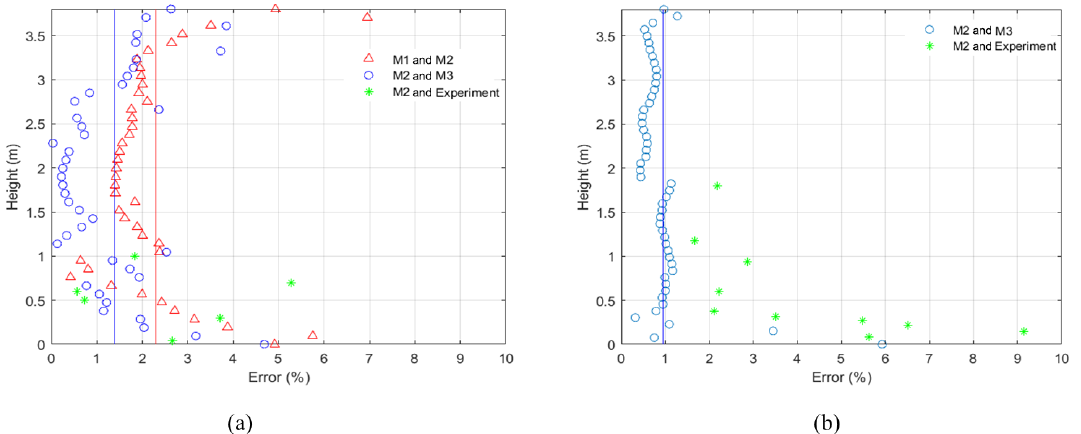
Figure 4. The relative errors for (a) low speed velocities (without contraction walls) and (b) high speed velocities (with contraction walls); the solid lines are the mean value for the errors over the whole height.